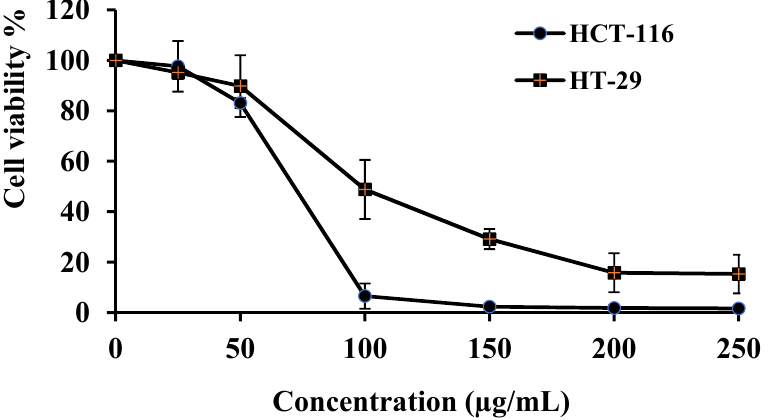
Figure 8. Cell viability of the HCT-116 and HT-29 cell lines after 72 h treatment with different concentrations of rosin using WST-1 assay. Results from three separate experiments: (mean ± SD).